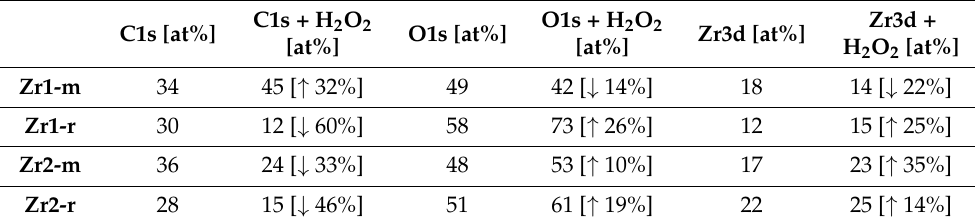
Table 1. Atomic percentages of the XPS detail spectra of the smooth and roughened surfaces for the C1s, O1s and Zr3d electrons without and with H 2 O 2 -treatment (arrows pointing upwards indicate an increase, arrows pointing down indicate a decrease in the corresponding elements).